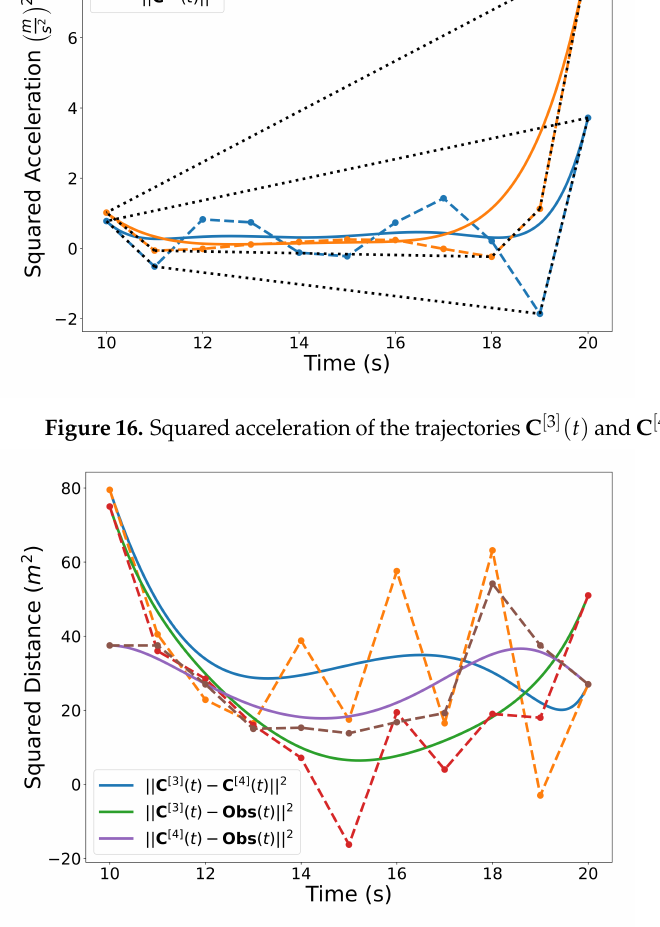
Figure 17. Squared distances between the trajectories and then center of the spherical